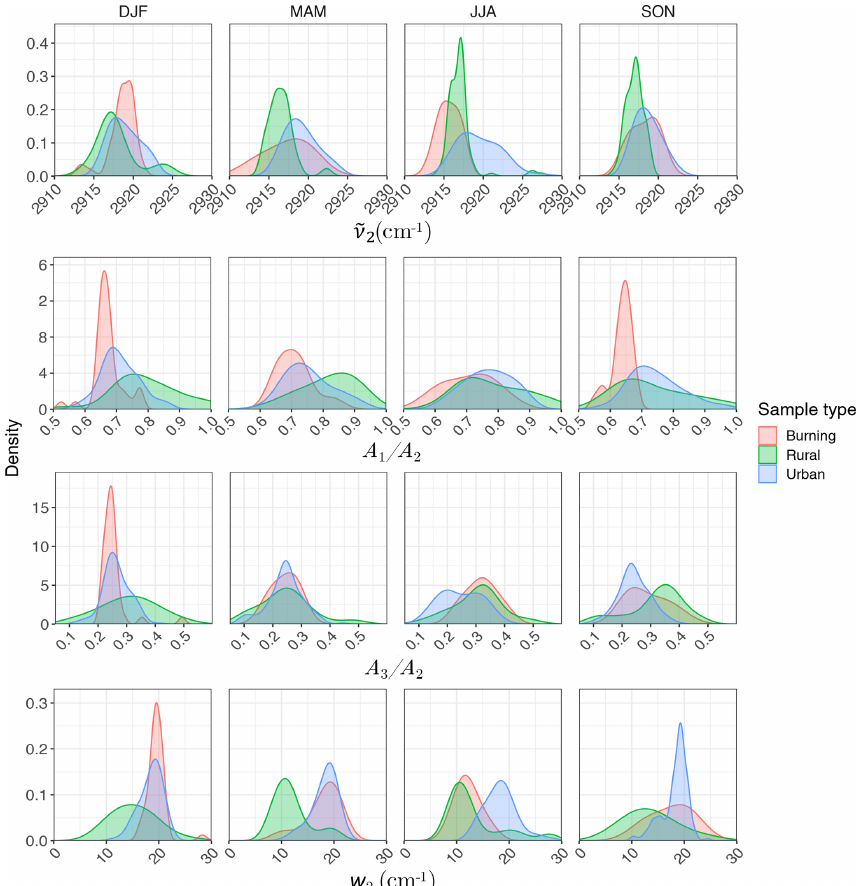
Figure 7. Kernel density estimate of second peak wavenumber ( ˜ ν 2 ), the ratio of peak heights of symmetric CH 2 to asymmetric CH 2 stretching ( A 1 /A 2 ), the ratio of peak heights of asymmetric CH 3 to asymmetric CH 2 stretching ( A 3 /A 2 ), and the second peak width ( w 2 ) of the aliphatic C − H band in the mid-infrared spectra of the atmospheric samples segregated based on sample type and